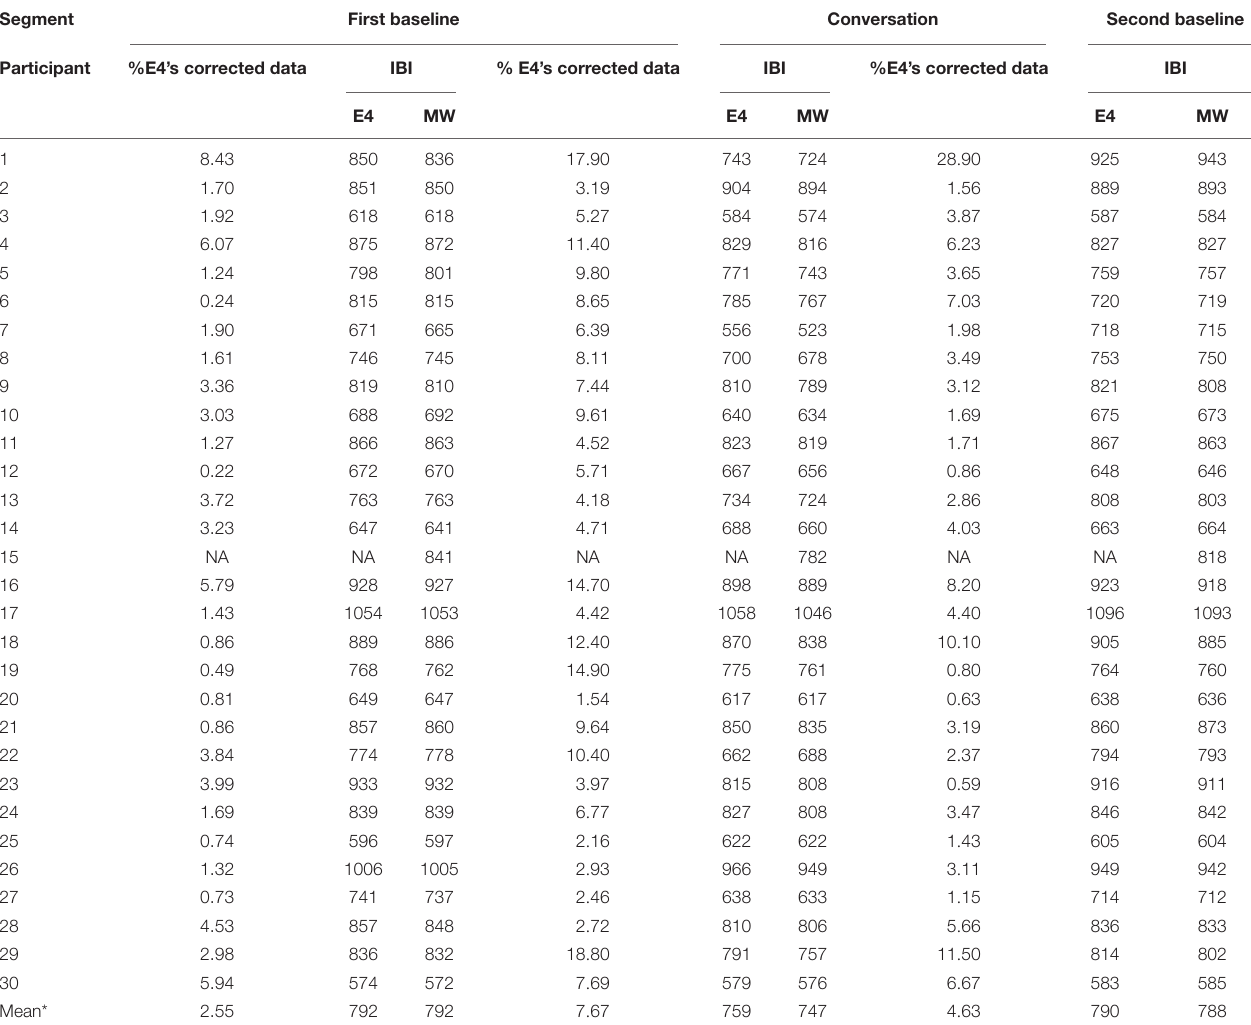
TABLE 1 | Mean IBI obtained by the E4 and by MW mobile device for each participant, in each of the three segments of the experiment, and percentage of data corrected by the external Software in the three segments. Segment First baseline Conversation Second